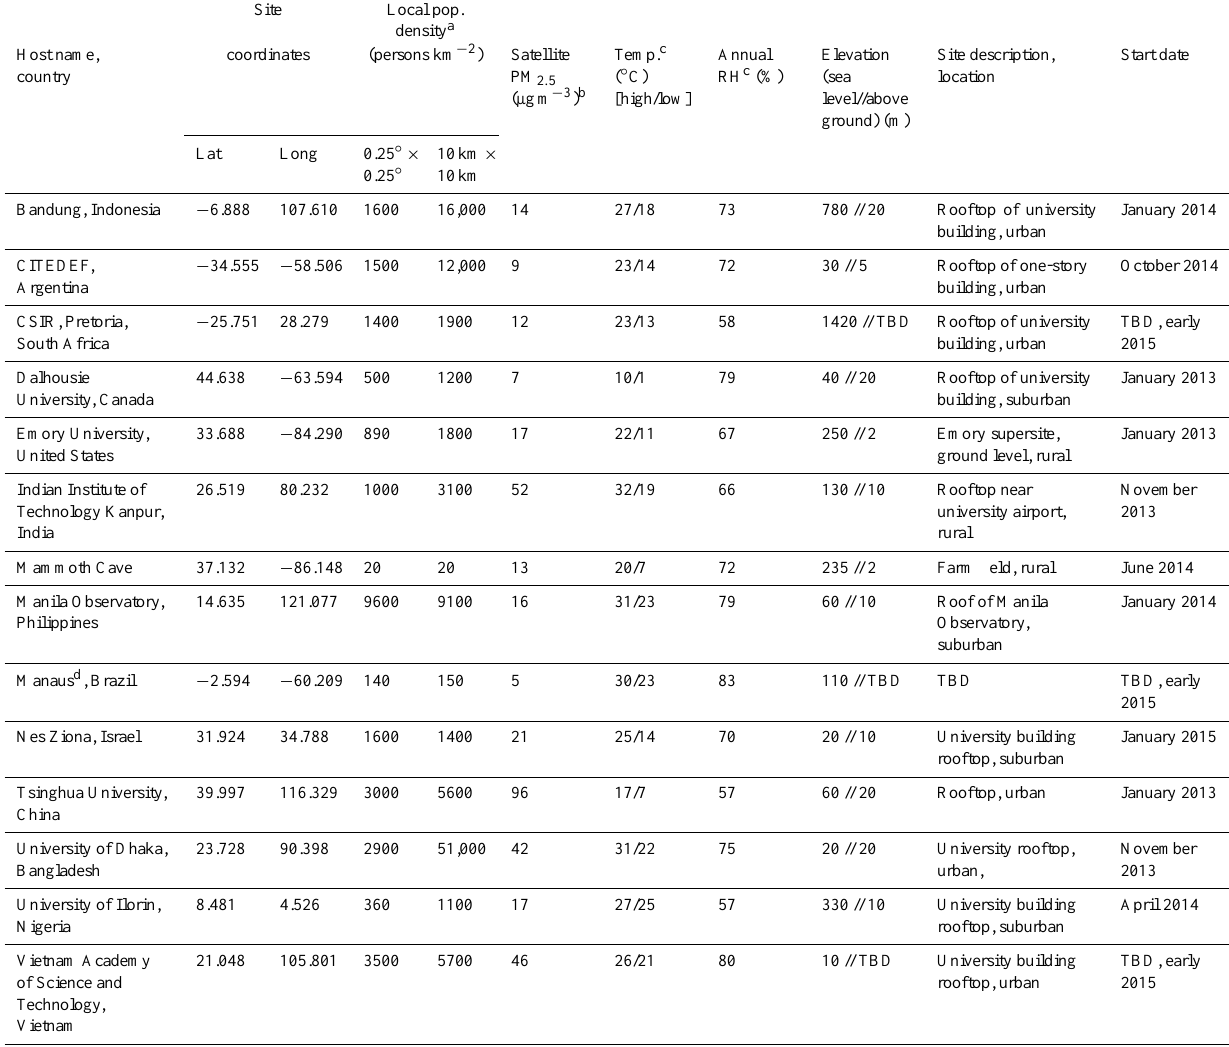
Table 1. Site information for confirmed SPARTAN station